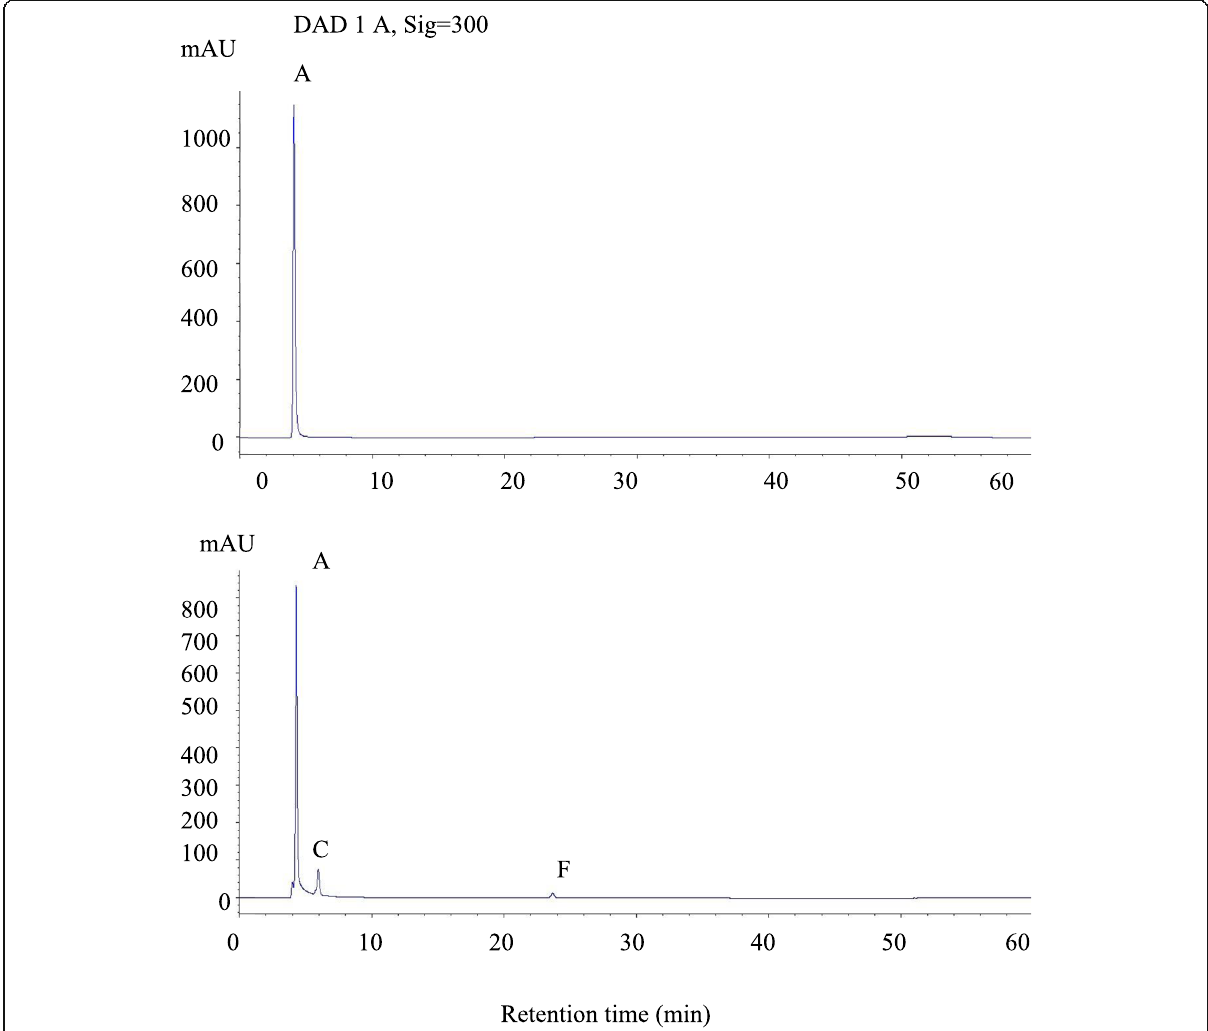
Fig. 2 High-performance liquid chromatography (HPLC) chromatograms of starting materials (top) and resultants (bottom) of acidolysis p - coumaric acid and triolein at 300 nm. A : p -coumaric acid; C : monooleyl p -coumarate; and F : dioleyl p